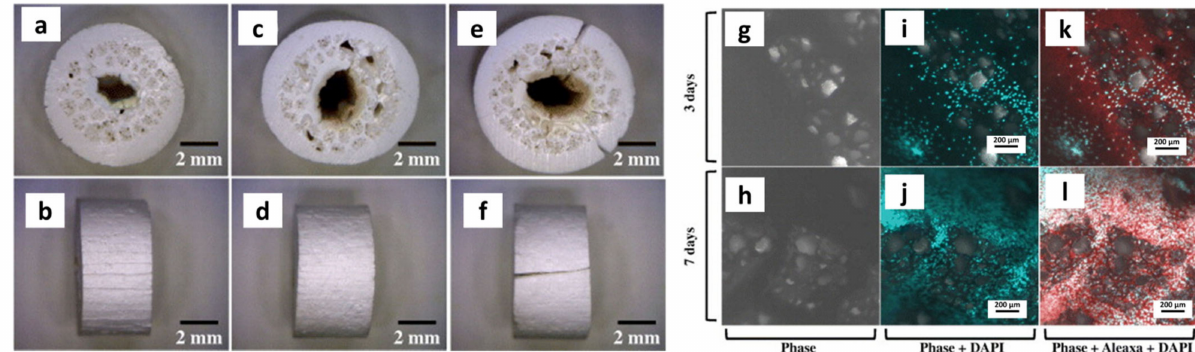
Figure 7. Photographs of HAp/t-zirconia composites sintered at 1300 ◦ C ( a , b ), 1400 ◦ C ( c , d ) and 1500 ◦ C ( e , f ). Confocal microscopy images of osteoblast cell proliferation on an HAp/t-zirconia composite scaffold sintered at 1400 ◦ C for 3 days ( g , i , k ) and 7 days ( h , j , l ). Reprinted with permissionfrom Lee et al. [77], copyright©